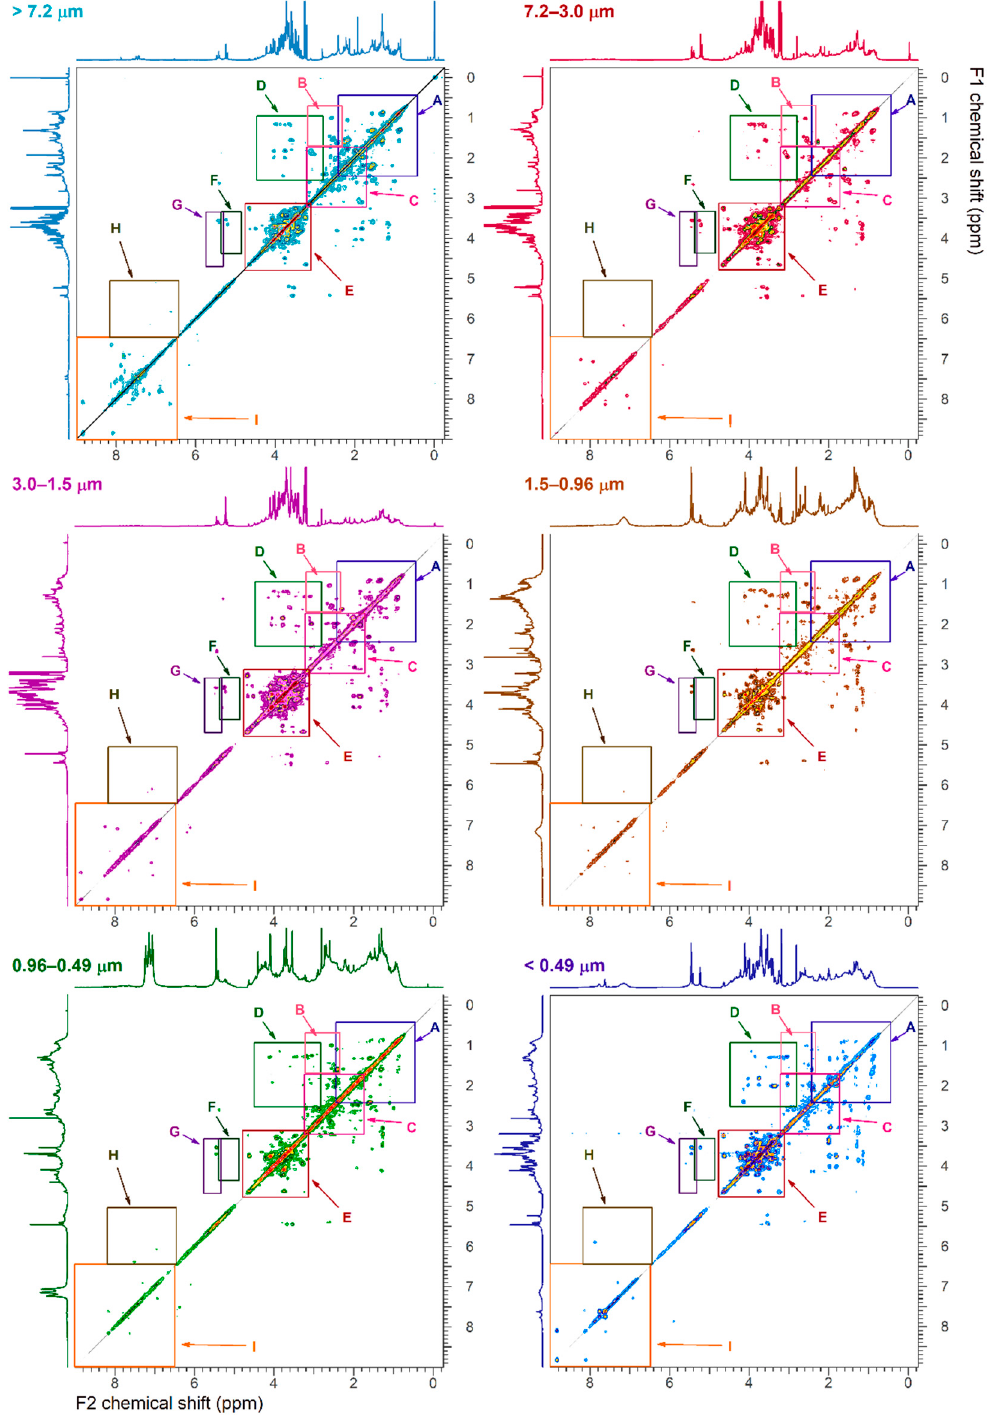
Figure 4. 1 H- 1 H COSY NMR spectra of size fractionated particulate water-soluble organic carbon. The regions A, B, C, are detailed in Figure S1, the region D in Figure S4, the region E, F and G in Figure S5 and the region I in Figure S8. The x-axis F2 represents the proton frequencies obtained in the direct dimension and the y-axis F1 represents the proton frequencies obtained in the indirect dimension.